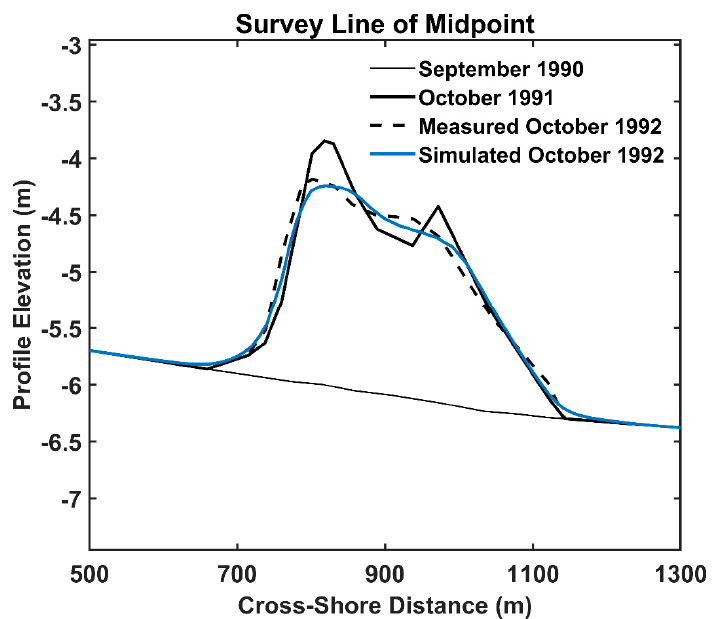
Figure 7. Calculated and measured profiles one year after mound disposal at the midpoint of mound.